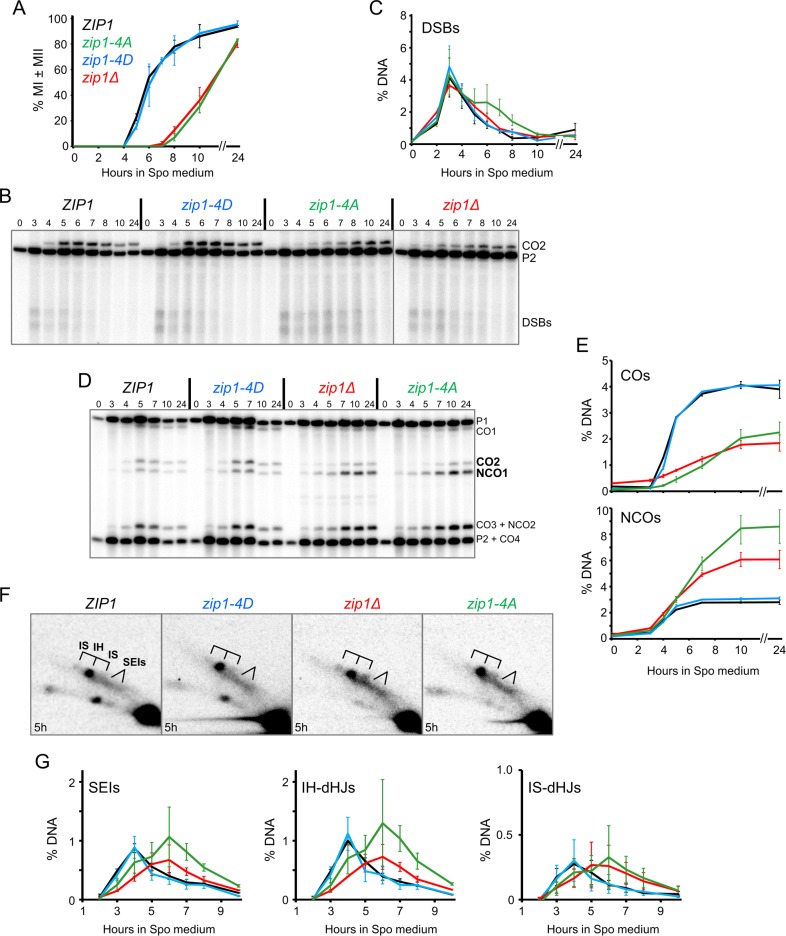
Meiotic time course analysis of various zip1 diploids.Homozygous WT (NH2297::p3822), zip1-4D (NH2297::p382-4D2), zip1Δ (NH2297::pRS3042), and zip1-4A (NH2297::p382-4A2) diploids were sporulated and cells taken at different time points. (A) Meiotic progression was measured by counting the percentage of binucleate (MI) and tetranucleate (MII) cells after staining with 4’, 6-diamidino-2-phenylindole (DAPI). (B) DSBs detected by XhoI digestion of genomic DNA was probed with a fragment to detect the HIS4::LEU2 hotspot. (C) Quantification of DSBs from two different time courses, one of which is shown in Panel B. (D) COs and NCOs detected by XhoI/NgoMIV digestion of the DNA. (E) Quantification of CO2 and NCO1 as in Panel C. (F) Representative examples of JMs at the indicated time points. (G) Quantification of single end invasions (SEIs), IH, and intersister (IS) dHJs as in Panel C. Complete gels are shown in S2 Fig. For all panels, average values from two independent time courses are shown. Error bars indicate the range.